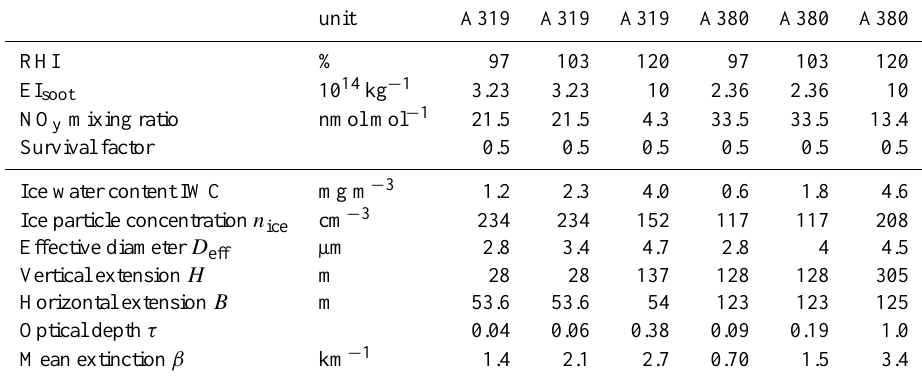
Table 5. Parameters used in the CoCiP bulk model and model results, in a presentation similar to Table